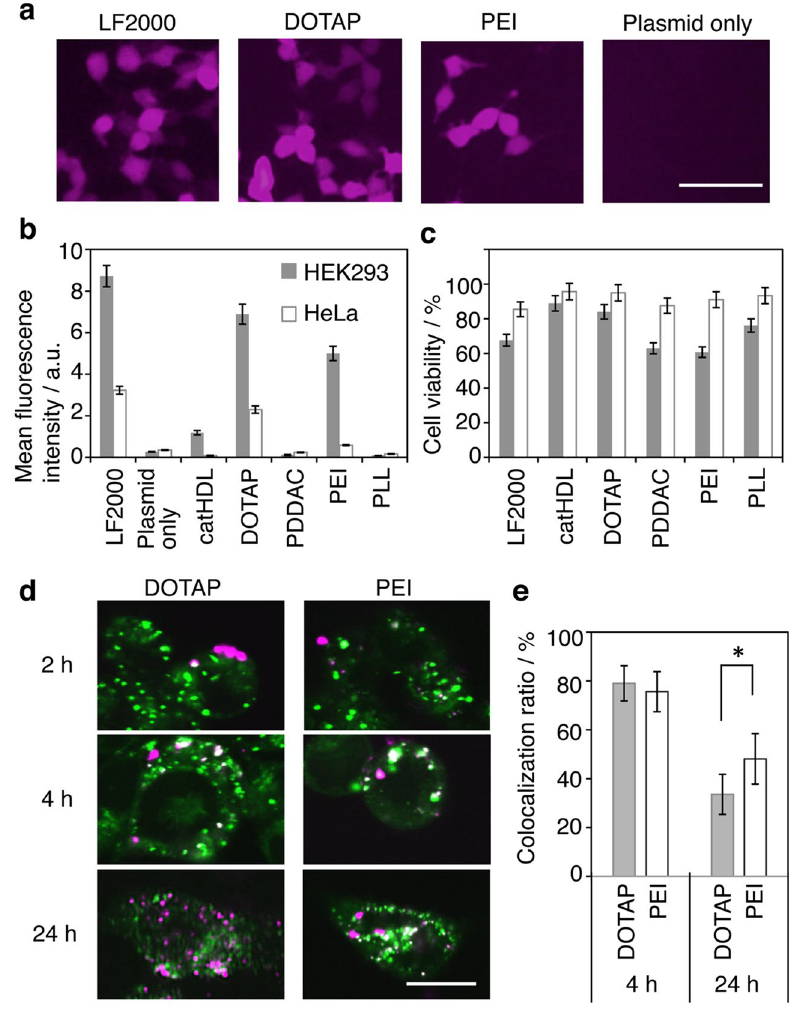
Figure 2. Intracellular gene delivery by cationic AuNRs. ( a ) Fluorescence images of HEK293T cells treated with cationic AuNR/pCMV-DsRed complexes. LF2000 was used as a positive control. Scale bar = 100 µ m. ( b ) Transfection efficiency determined by flow cytometry analysis. Data indicate the mean fluorescence intensity of DsRed (n = 3, average ± SD). HEK293T cells and HeLa cells were treated with AuNR/pCMV-DsRed complexes ([Au] = 20 µ g/mL, pCMV-DsRed = 2 µ g/mL) for 24 h. DOTAP-AuNRs show a high transfection efficiency, comparable to that of LF2000. ( c ) Cell Count Kit-8 (CCK-8) assay data for HEK293T cells and HeLa cells treated with AuNR/pCMV-DsRed complexes for 24 h. Data indicate the mean cell viability (n = 3, average ± SD). The cytotoxicity of cells treated with DOTAP-AuNRs is lower than that of those treated with LF2000. ( d ) Time-dependent change of the localization of AuNRs in HEK293T cells. DOTAP- and PEI- AuNRs were labeled with Rho-PE and Alexa Fluor 546, respectively. AuNR localization (red signal) was analyzed after 2, 4 and 24 h treatment. Late endosomes/lysosomes were stained with LysoTracker Green DND- 26 (LysoTracker, green). ( e ) The colocalization ratios of the red pixels to green pixels after 4 and 24 h were calculated, respectively (n = 10, average ± SD). Asterisks indicate P values < 0.05 determined using Student’s t-test. Scale bar = 10 µ